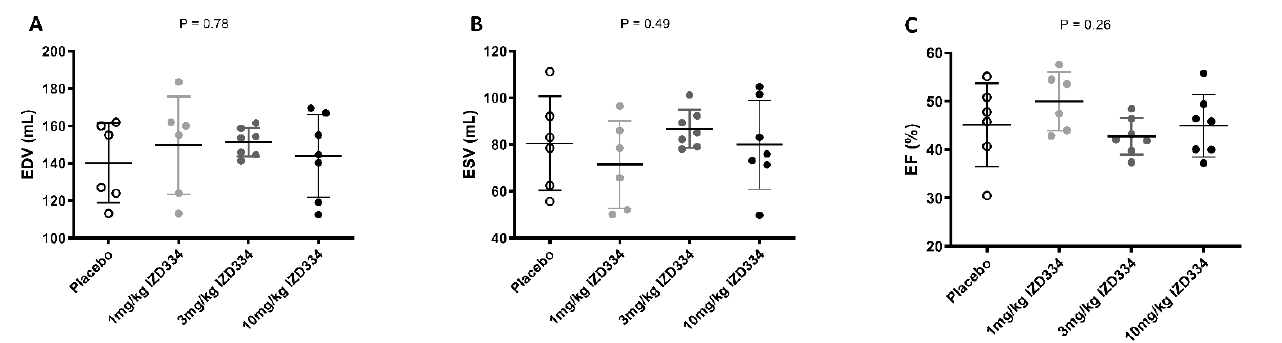
Figure 8. Global cardiac function measured by cardiac magnetic resonance imaging. Normal distribution of data was confirmed as described in our methods (using Shapiro–Wilk test). Hence, a one way-ANOVA was performed. No differences were observed among groups. ( A ) End diastolic volume (EDV) (placebo 140 ± 21 mL, 1 mg/kg IZD334 150 ± 26 mL, 3 mg/kg IZD334 151 ± 8 mL, 10 mg/kg IZD334 144 ± 22 mL, ANOVA p = 0.78). ( B ) End systolic volume (ESV) placebo 81 ± 20 mL, 1 mg/kg 72 ± 19 mL, 3 mg/kg 87 ± 8 mL, 10 mg/kg 80 ± 19 mL, ANOVA p = 0.49. ( C ) Ejection fraction percent (EF%) (placebo 45.1 ± 8.7%, 1 mg/kg 49.9 ± 6.1%, 3 mg/kg 42.7 ± 3.8%, 10 mg/kg 44.9 ± 6.4%, ANOVA p = 0.26). Table 1. Infarct size and cardiac function 7 days after MI and treatment. AAR, area at risk; LV, left ventricle; IS, infarct size. EDV, end-diastolic volume; ESV, end-systolic volume; EF, ejection fraction.